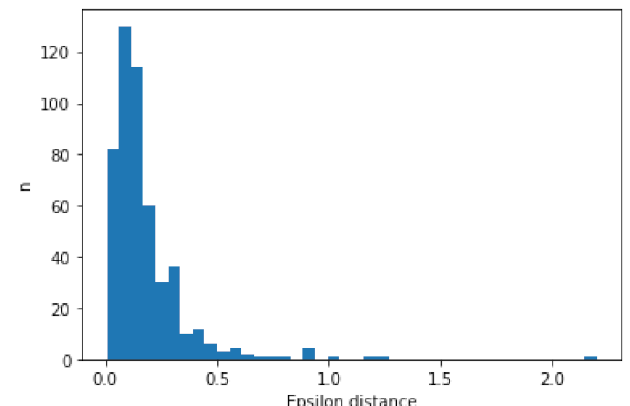
Figure 6. The k-distance graph of k = 1 distance to the nearest neighbor (elbow in value